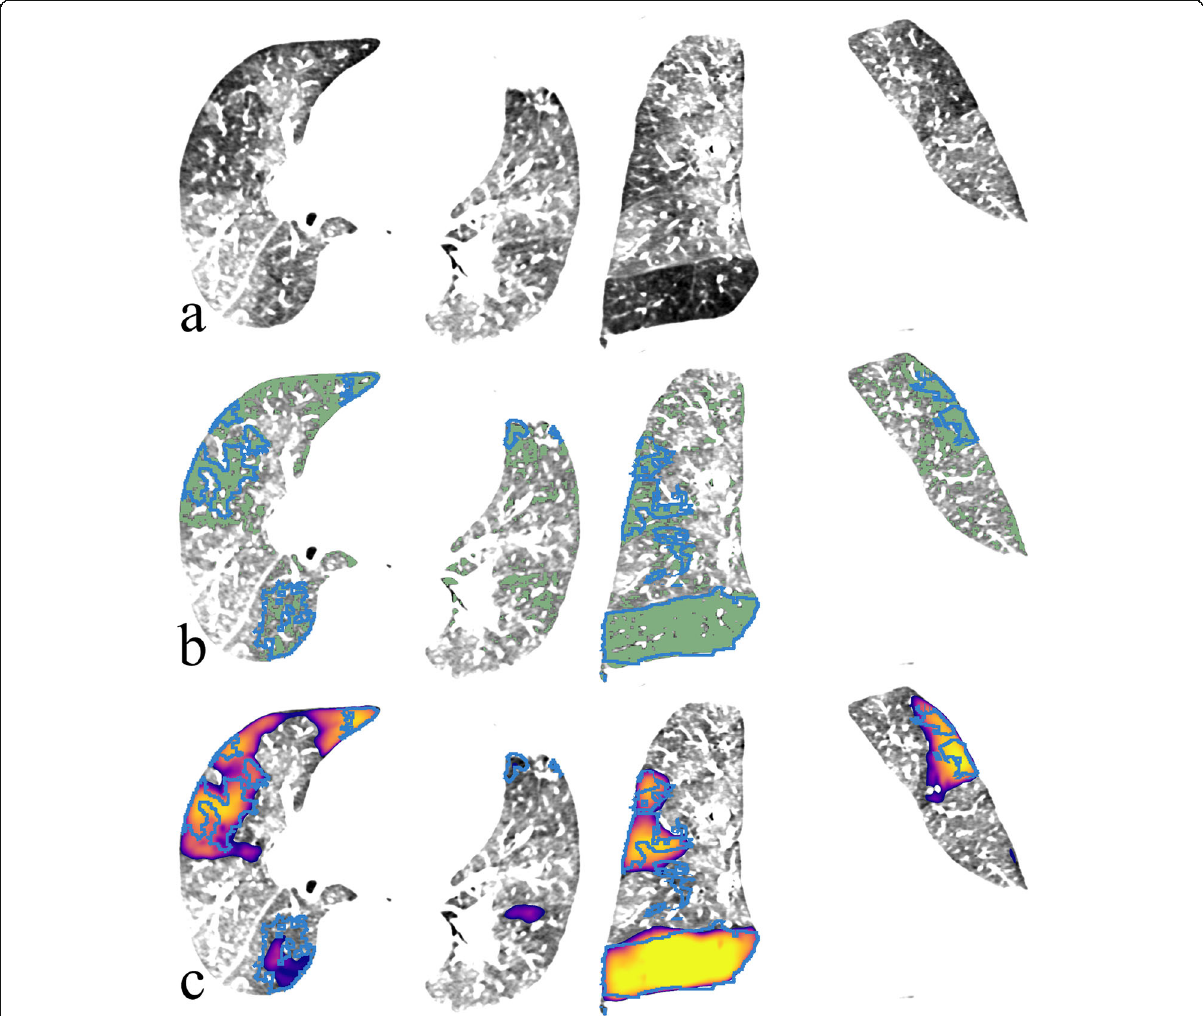
Fig. 2 An example of computed tomography angiography volume ( a ) segmentations with good agreement to manual delineations (blue outline): HU threshold ( ≤ -850)-derived segmentation is shown in green ( b ), while the prediction of convolutional neural network is shown as colourmap ( ≥ 0.37 probability cutoff) ( c ). HU Hounsfield